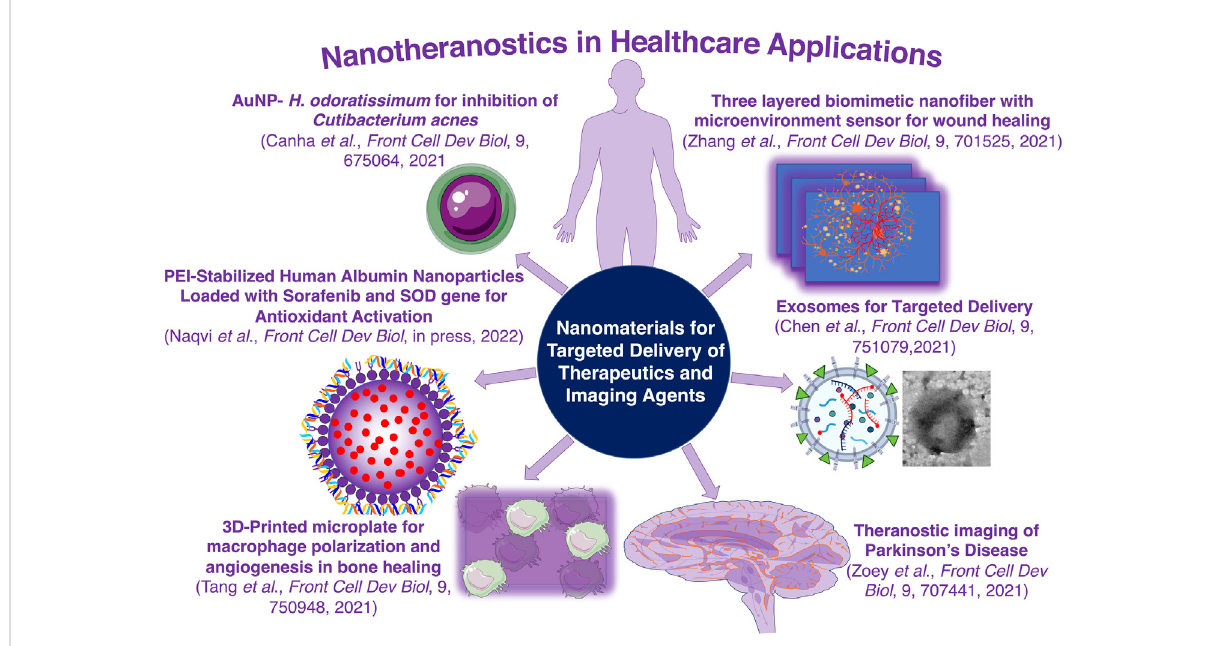
FIGURE 1 Schematic illustration of theranostic nanoparticles of various types in healthcare applications covered in this special issue.